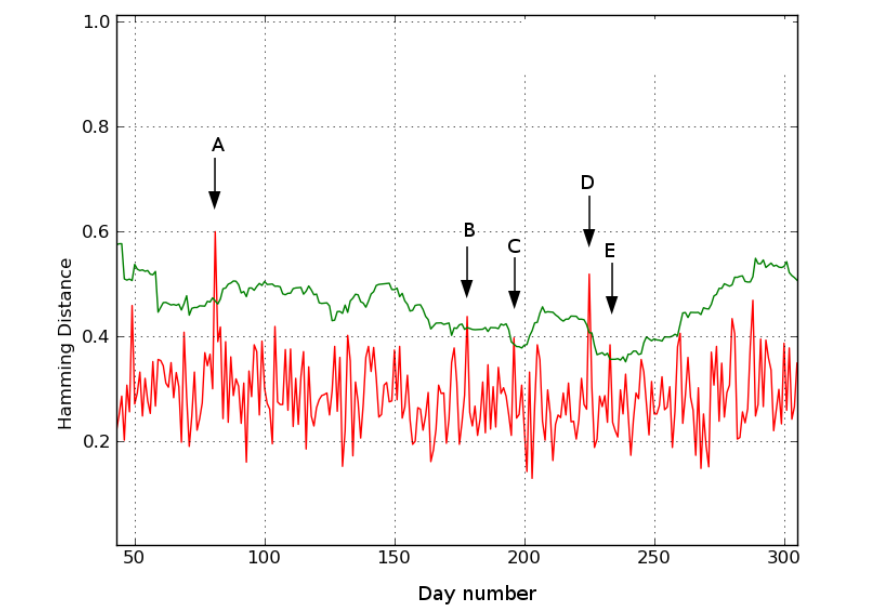
Figure 8. Location 1: Each day’s Hamming distance compared to its reference day using n = 21 days and τ = 60 s. The green line is the threshold calculated by Equation (2). Distances exceeding the threshold are indicated by an arrow and represent a deviation (green line is calculated threshold, red line is hamming distance) ‘A’, ‘B’, ‘C’, ‘D’, ‘E’ indicate detected deviating days. Location 2. Figure 9 shows the results for location 2, where days 60 (A), 62 (B), 63 (C), and 64 (D) are identified as